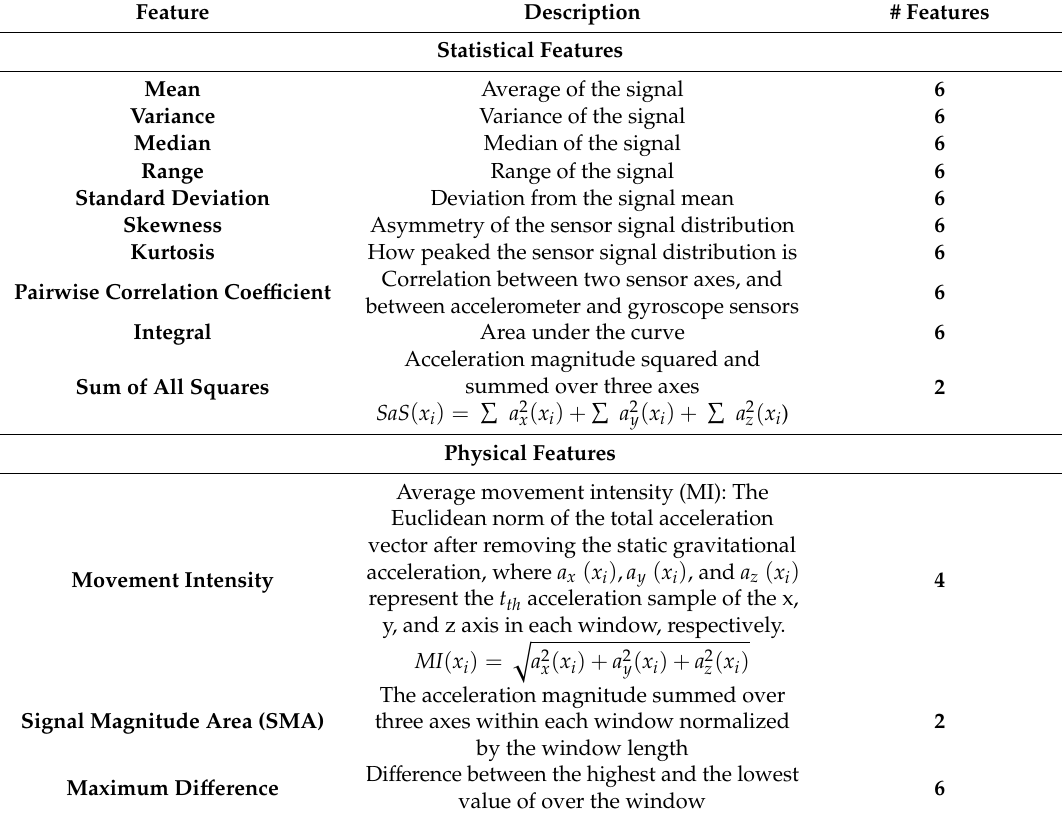
Table 2. Feature